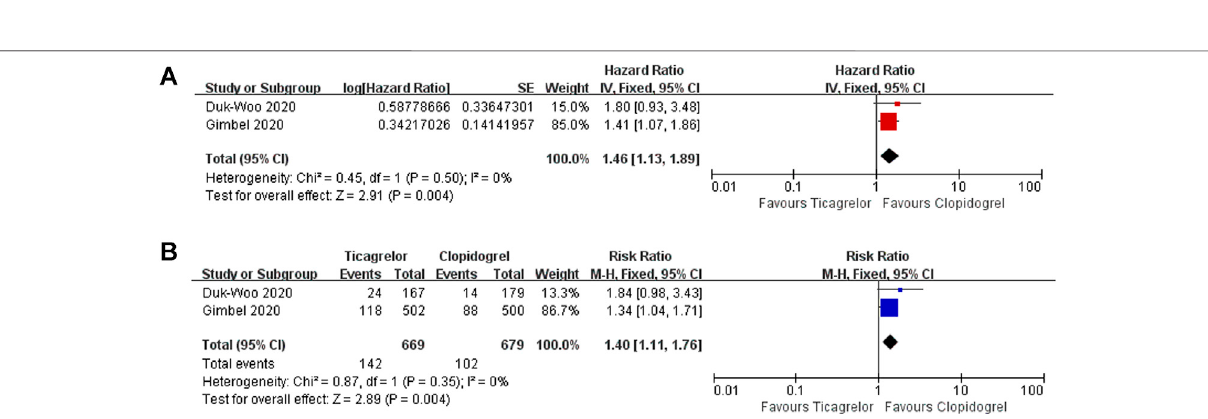
Frontiers in Pharmacology |